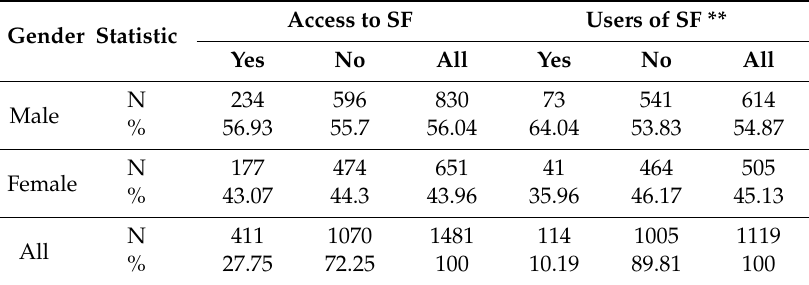
Table 8. Access to and use of seasonal forecast by gender and adoption.